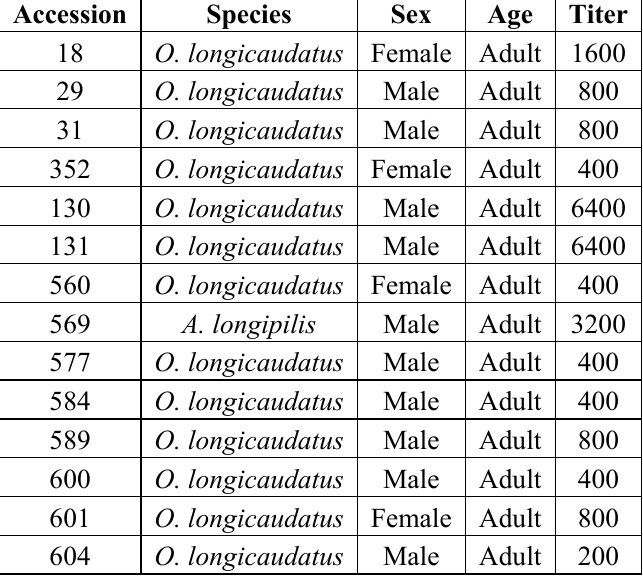
Table 2. Titers (expressed as the reciprocal of the O.D. dilution that yields a positive result) of seropositive samples to hantavirus in